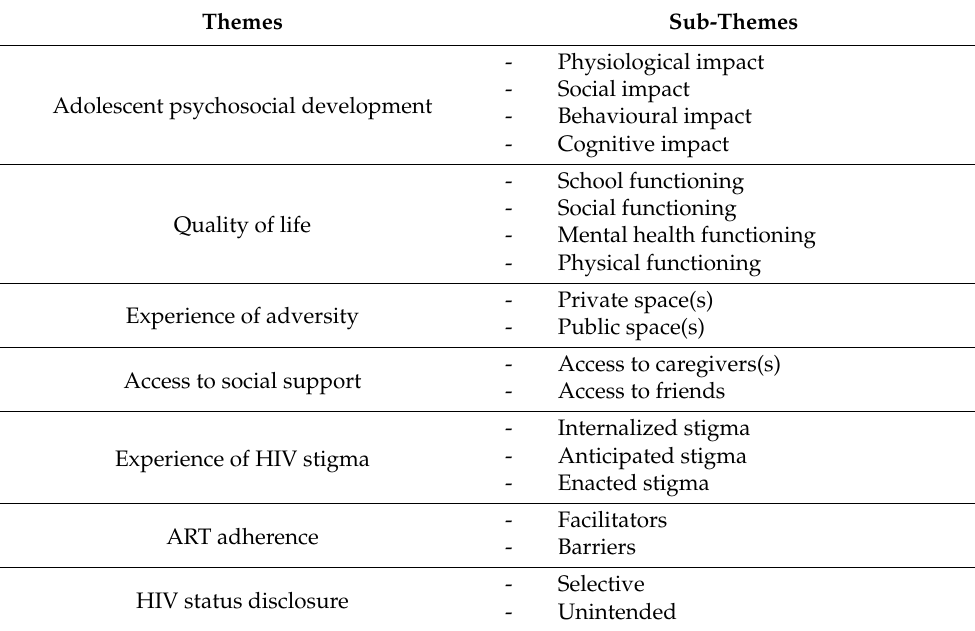
Table 4. Themes and Sub-themes Embedded Within the Included